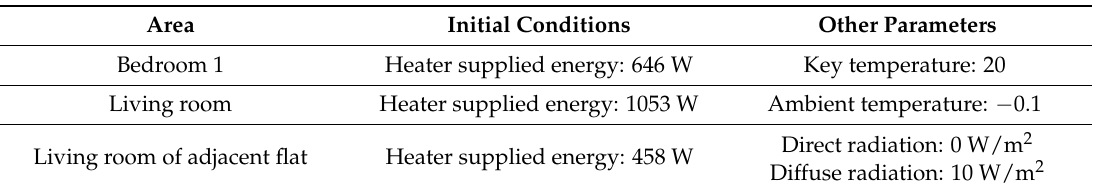
Table 4. Experimental